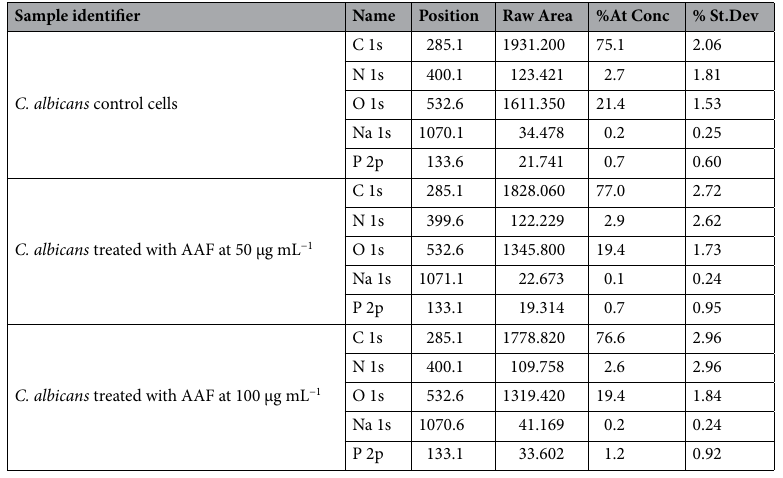
Table 3. Quantitative results of the XPS elemental composition analysis of the surface of C. albicans control cells and C. albicans cells incubated with AAF at a concentration of 50 µg mL −1 and 100 µg mL −1 .